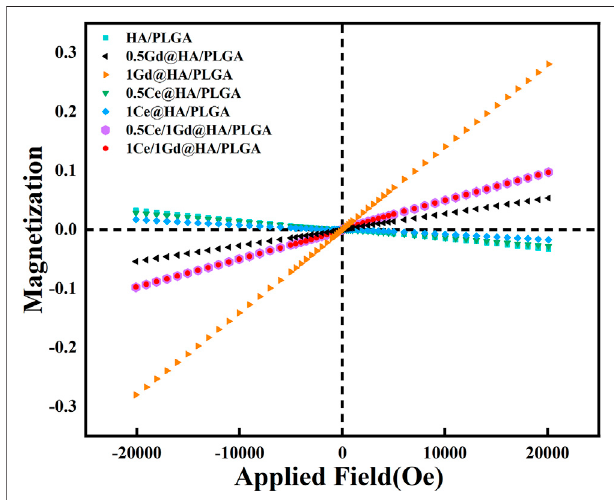
FIGURE 3 | Magnetization curves for synthesized HA, 0.5Ce@HA, 1Ce@HA, 0.5Gd@HA, 1Gd@HA, 0.5Ce/1Gd@HA, and 1Ce/1Gd@HA